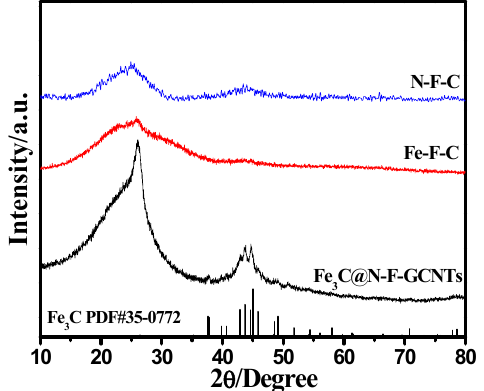
Figure 2. XRD patterns of Fe 3 C@N-F-GCNTs, Fe-F-C, and N-F-C.